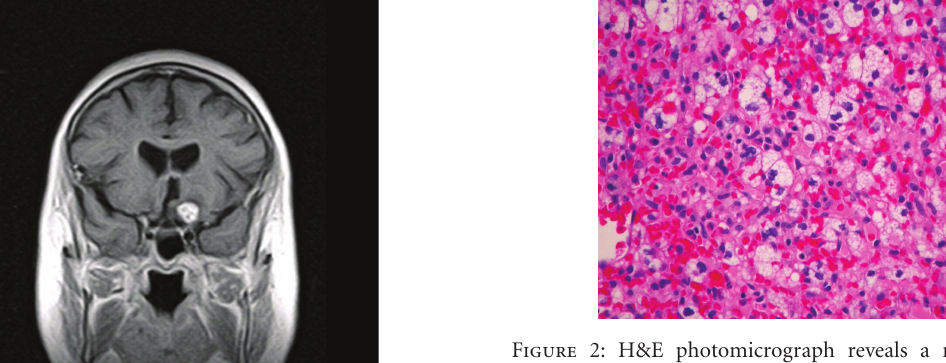
Figure 2: H&E photomicrograph reveals a markedly vascular tumor with lipidized stromal cells ( × 200).